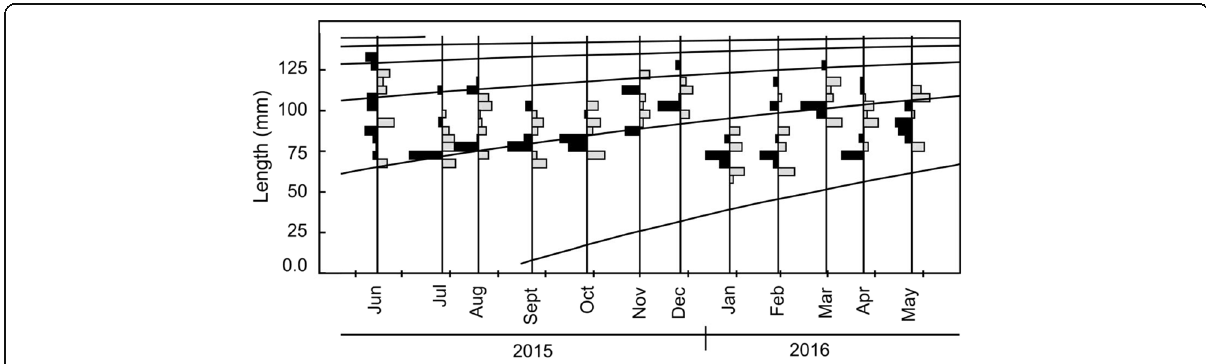
Fig. 2 The von Bertalanffy growth curve superimposed over length – frequency data of Pachypterus khavalchor from the Panchaganga River, Maharashtra,